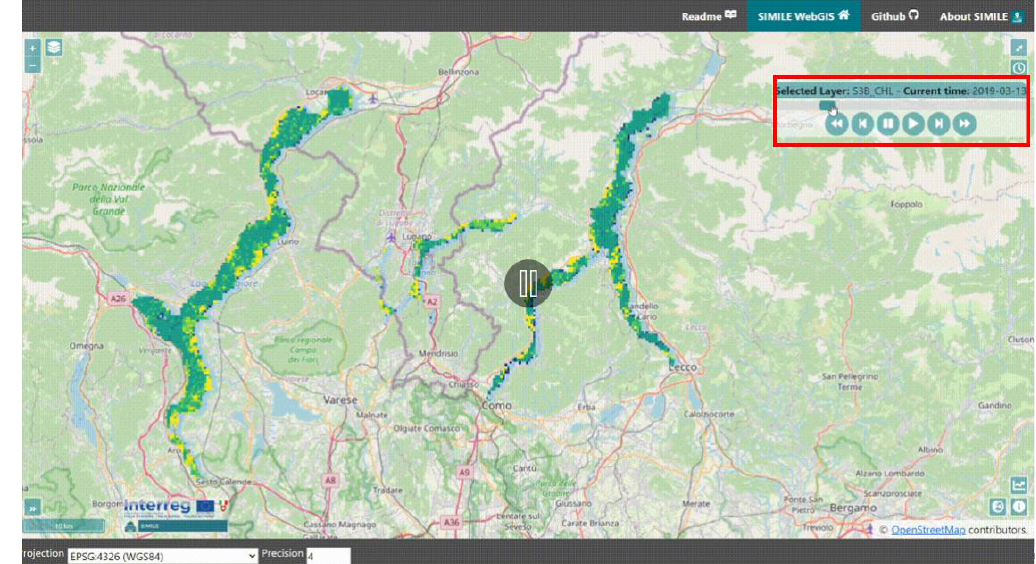
Figure 5. Time widget - Example Sentinel3B Chlorophyll-a